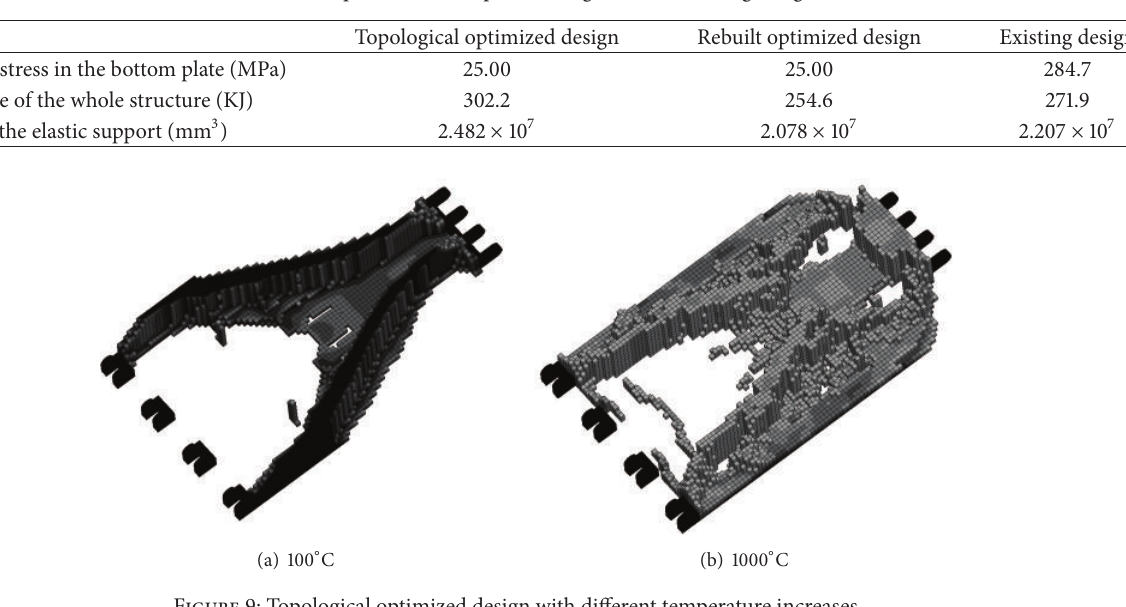
Table 4: Comparison of the optimal design and the existing design.